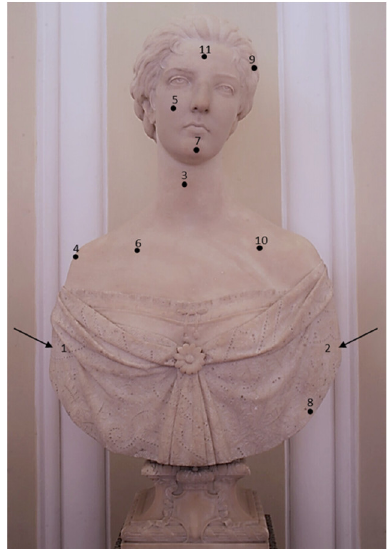
Figure 1. Measure points map. The arrows indicate the points on the back of the statue (points 1 and 2).